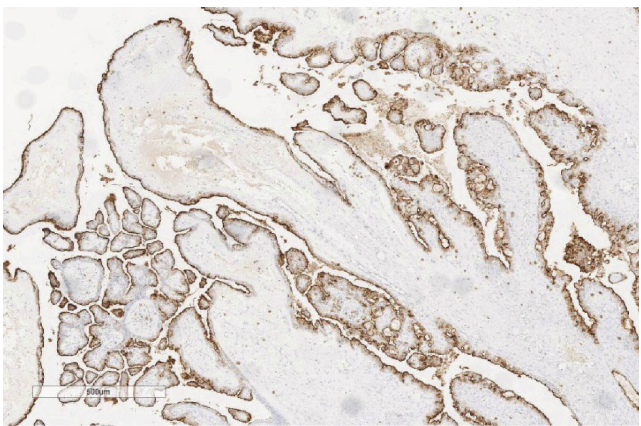
Figure 5: Epithelial membrane antigen.